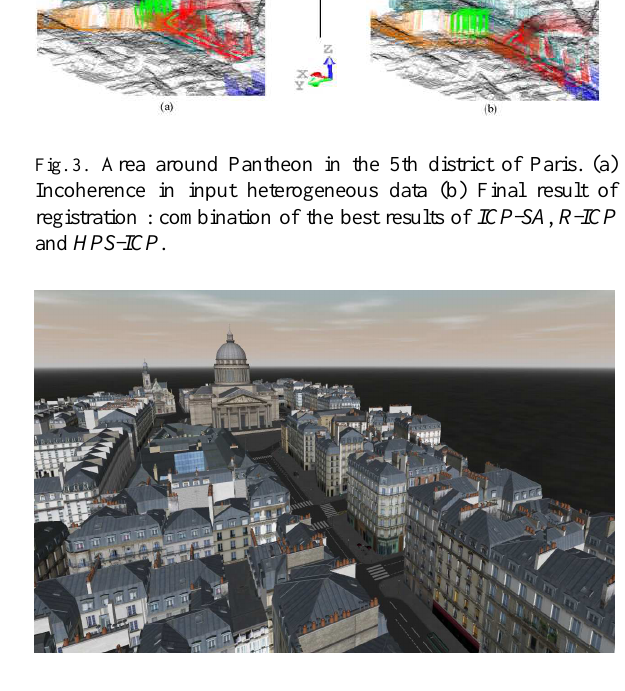
Fig. 4. Result of modelization based on 3D data produced by heteregeneous